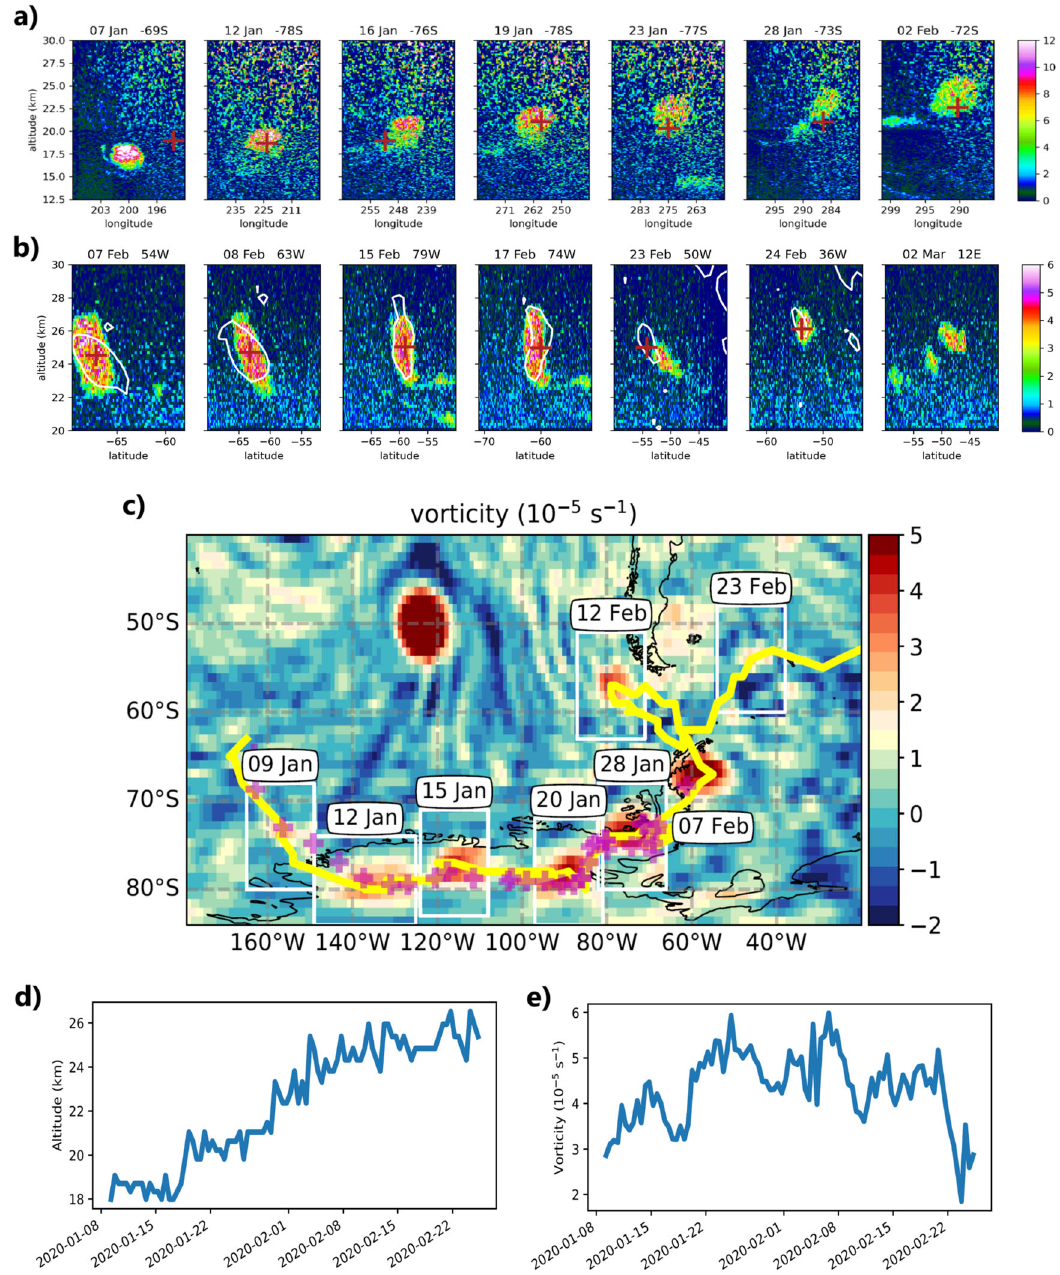
Fig. 9 Spatiotemporal evolution of the third vortex. a Time evolution of the vortex from 7 matching sections of CALIOP during its fi rst period over Antarctica. We use here daily orbits of CALIOP, hence the high level of noise. The x -axis is mapped over longitude due to the proximity of the pole. b Time evolution of the third vortex from 7 matching sections of CALIOP during its second period. c Time evolution of the vortex according the ECMWF analysis from eight vorticity snapshots at the level of maximum vorticity. The background is shown for 7 February where the main vortex is also visible. The yellow curve shows the trajectory of the vortex in the IFS, the magenta crosses mark the TROPOMI AI centroid. d Altitude of the vortex core as a function of time. e Maximum vorticity of the vortex core as a function of